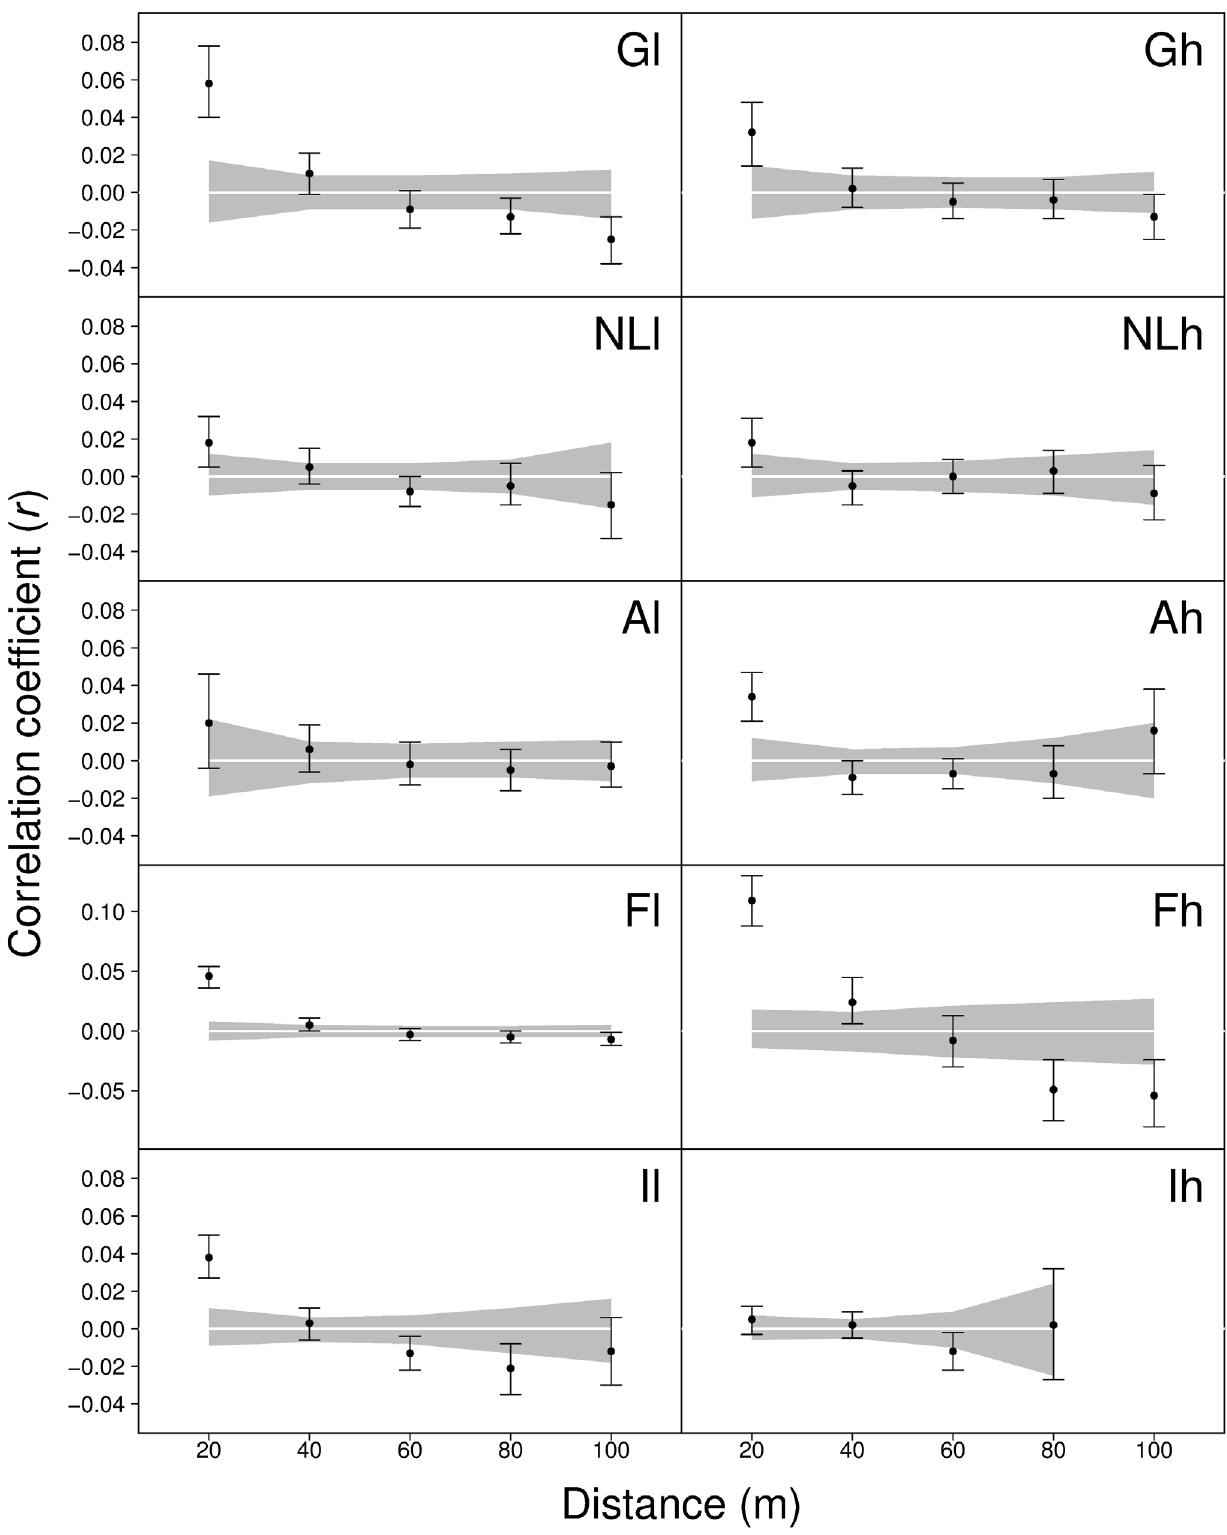
Figure 1. Correlograms from spatial autocorrelation analysis using the correlation coefficient r by Smouse & Peakall [ 29 ] and even distance classes. Shaded areas represent the 95% confidence interval obtained through random shuffling (1000 times) of individual geographic locations, black lines around mear r values represent 95% confidence intervals around mean r values generated by bootstrapping (1000 times) pair- wise comparisons within each distance class.